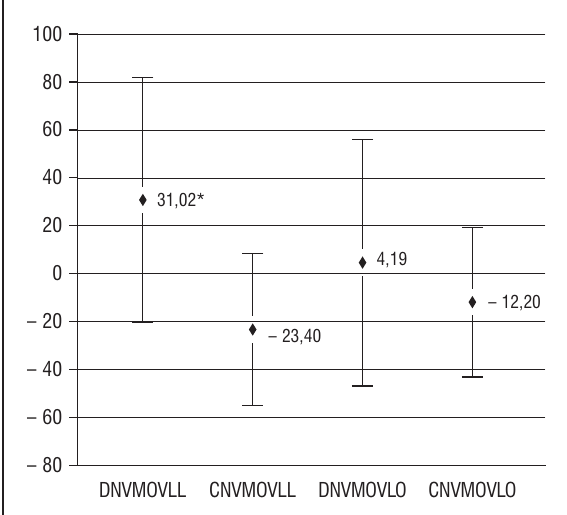
Figura 1 - Diferença relativa no onset eletromiográfico para os sujeitos dos grupos SDFP e GC na marcha em